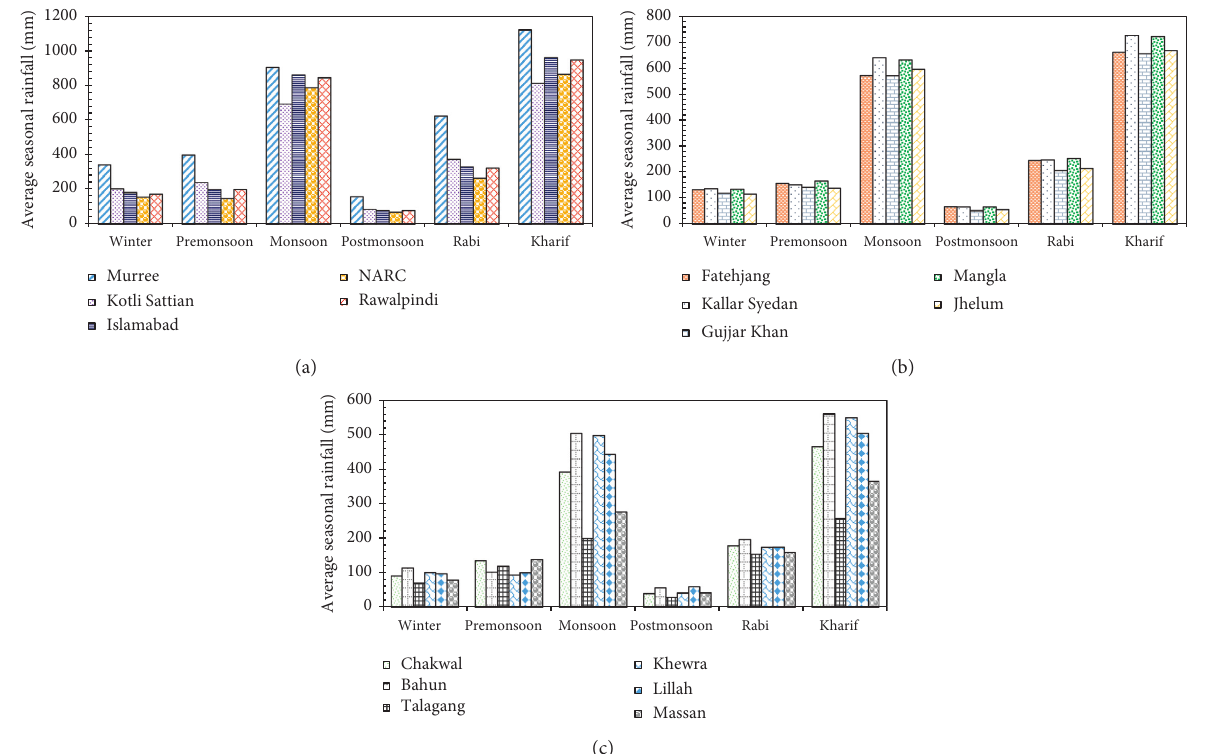
Figure 4: Mean seasonal (winter, premonsoon, monsoon, postmonsoon, Rabi, and Kharif) rainfall comparison of the study area in (a) zone- 1, (b) zone-2, and (c) zone-3, respectively.